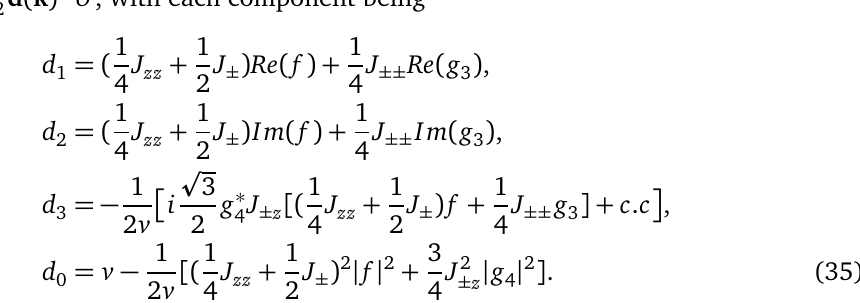
= 1; J = 0.9; J = 1; J = 0.3; v = ± ±± ± z zz